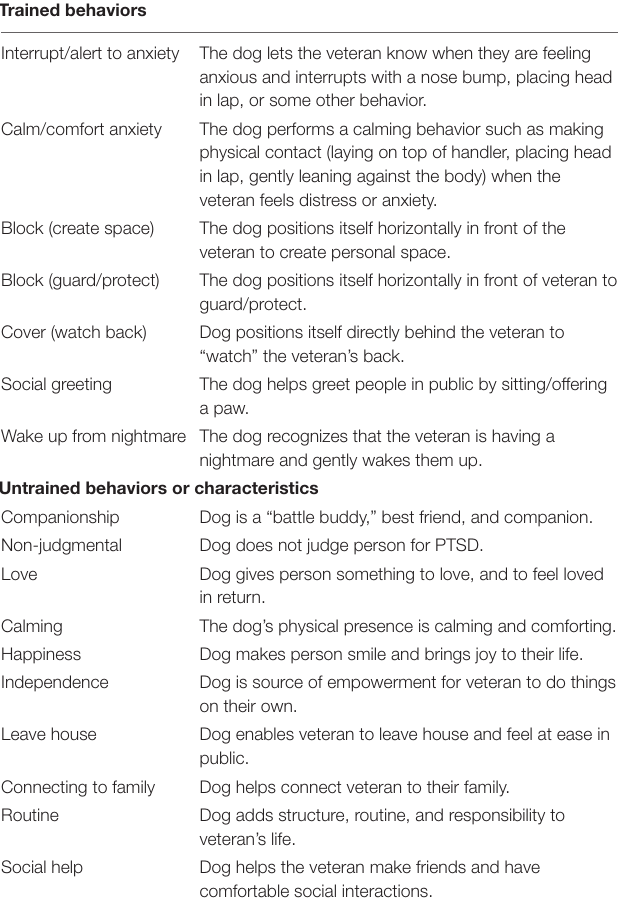
TABLE 1 | Service dog trained behaviors and untrained behaviors or characteristics as described to participants in the survey. Trained